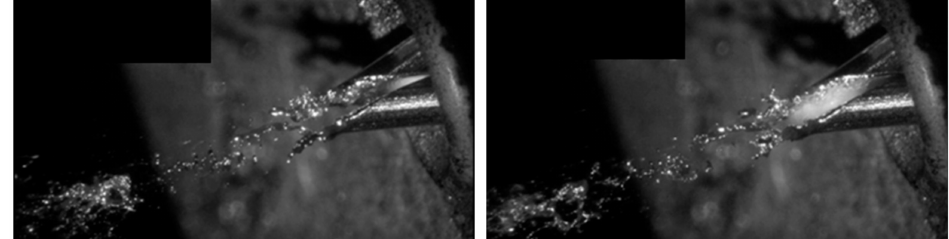
Figure 3. Particle formation during wire arc spraying with direct current at time ( left ): t = 35.85 ms, ( right ): t = 35.90 ms.